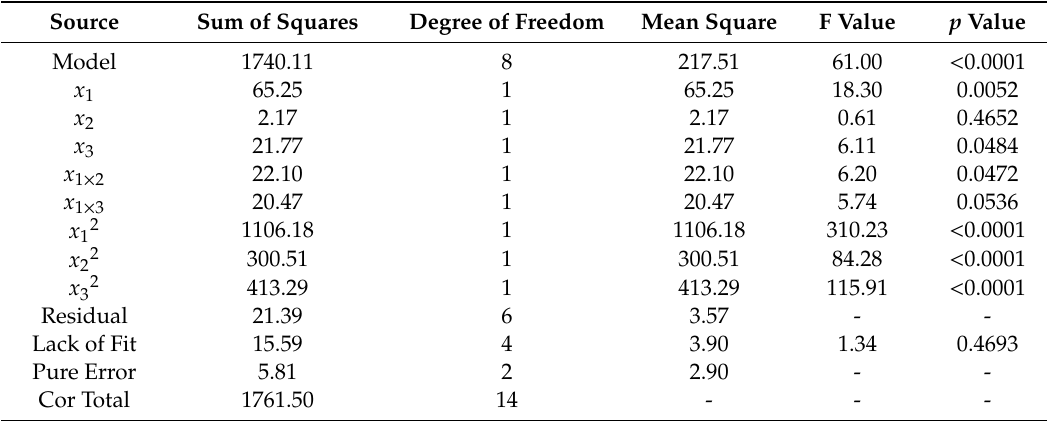
Table 5. Analysis of variance (ANOVA) for the regression model of hydrogen